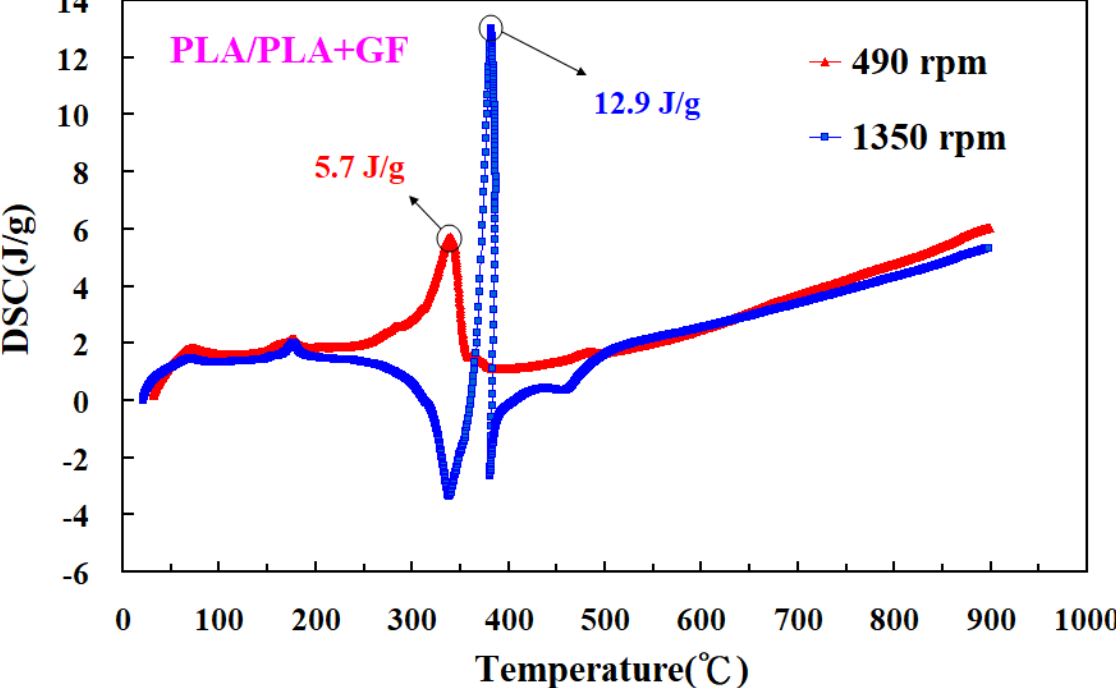
Figure 16. DSC curves for samples welded at 490 rpm and 1350 rpm.